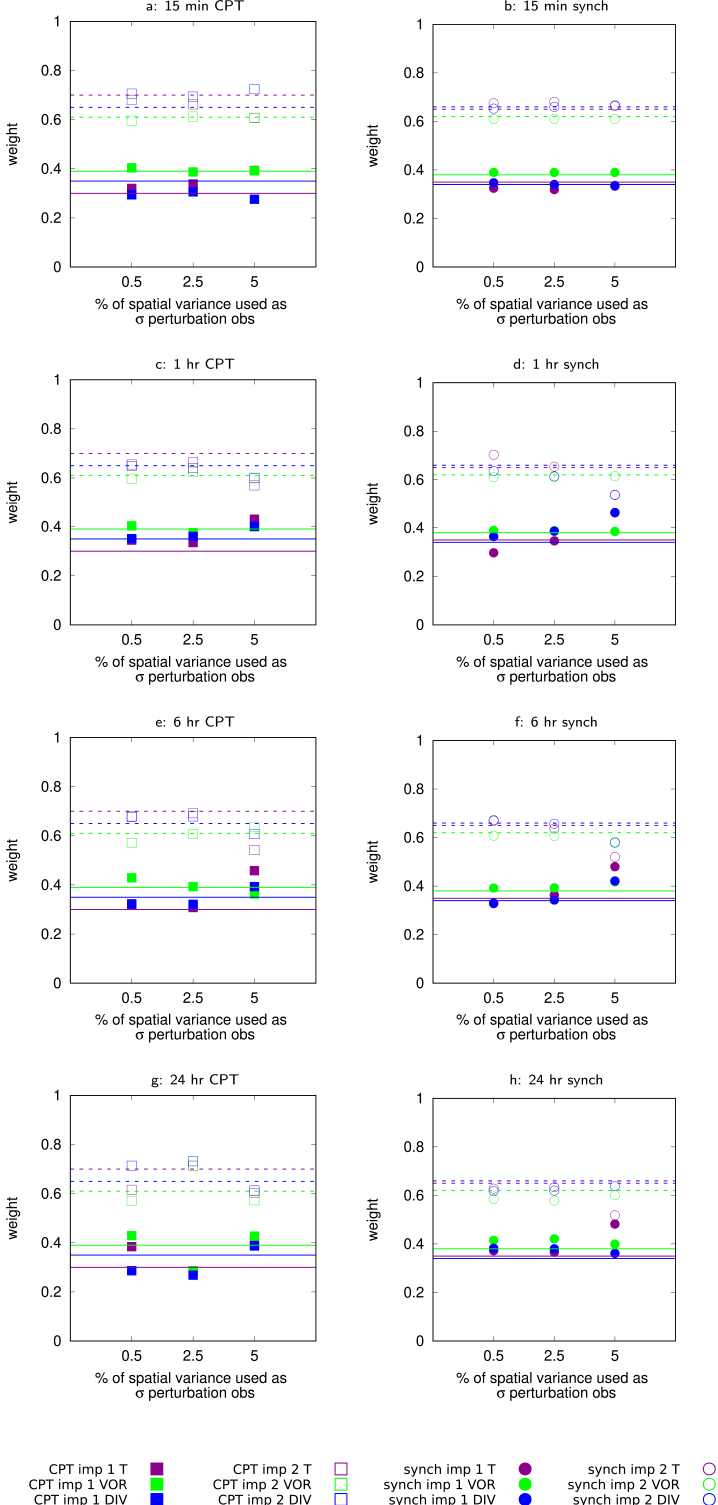
Figure 3. Weights for the supermodel trained by CPT and the synch rule. The horizontal lines (continuous for model 1, dashed for model 2) indicate the weights obtained by CPT and synch rule training in Schevenhoven et al. (2019), in which case the observations were perfect and available at every time